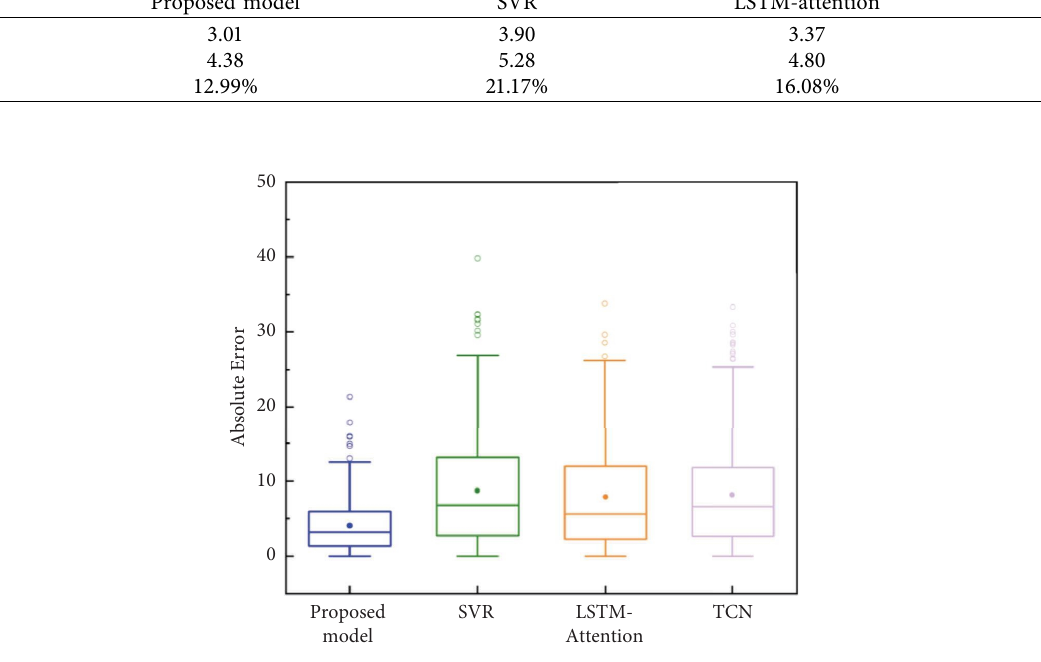
Figure 4: Te box chart comparison.